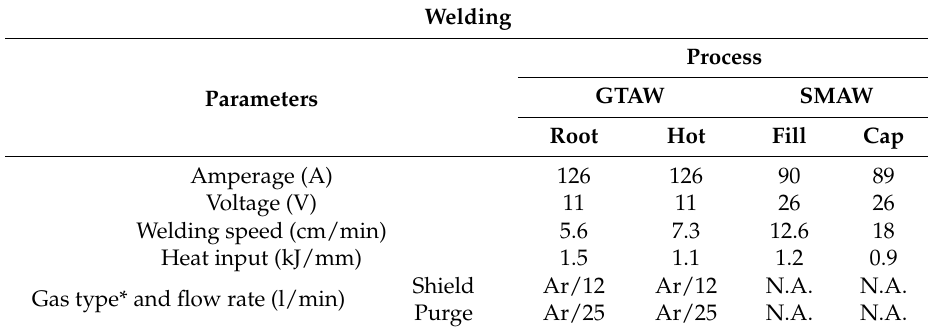
Table 3. Processes and parameters adopted to girth weld the 9% Ni quenched and tempered steel tubular butt joint with Ni-based superalloy 625 as the filler metal.